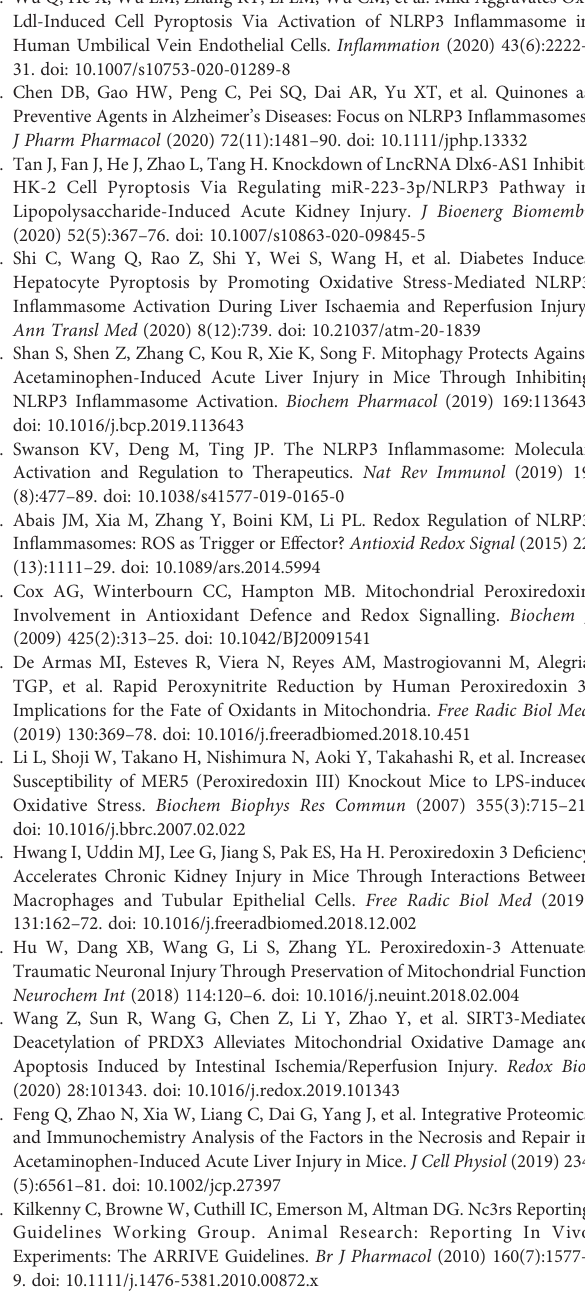
Supplementary Figure 1 | Primary hepatocytes were transfected with speci fi c siRNAs of PRX3, PRX5 and PRX6 prior to APAP-induced cytotoxicity. (A – C) PRX3,